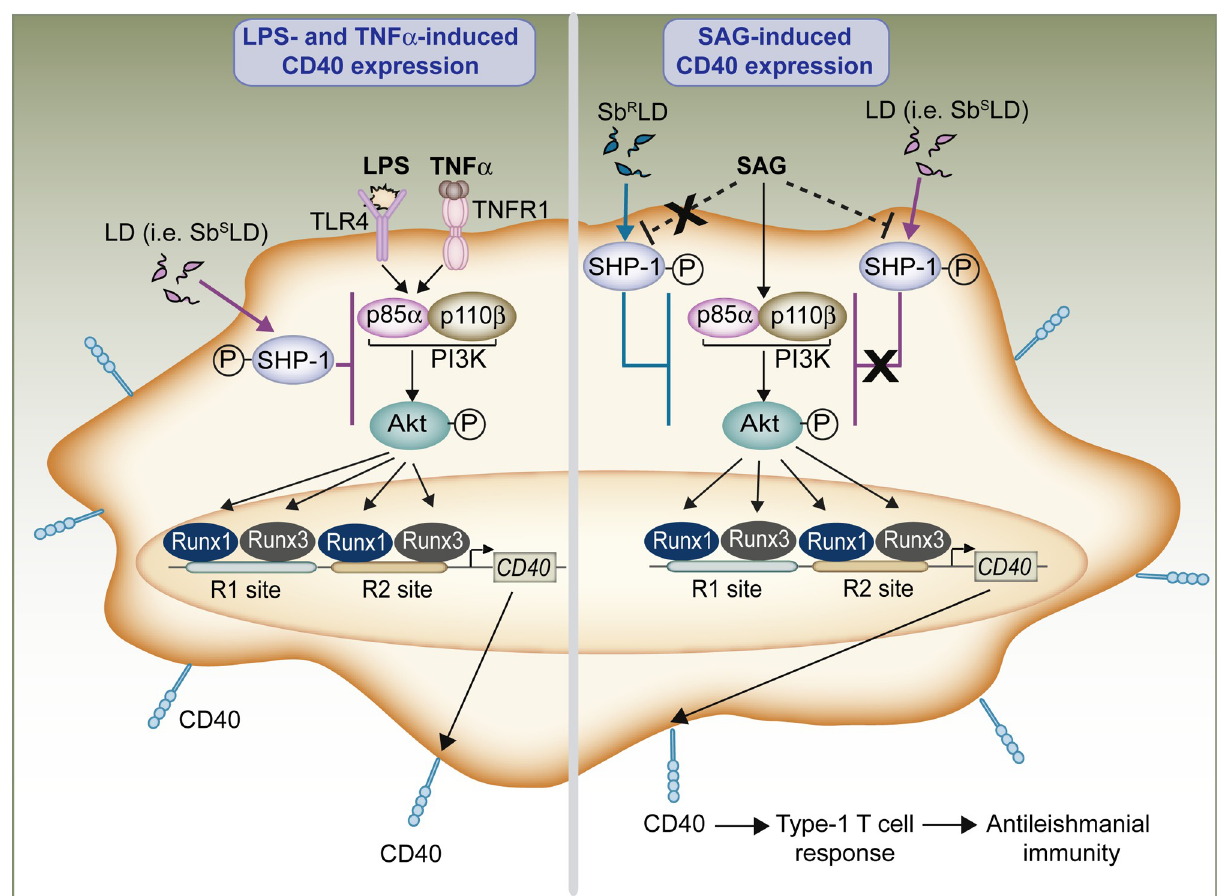
Fig 13. Model depicting the Runx-CD40 axis as a molecular key for antileishmanial immunity. Our results show that the proinflammatory mediators LPS and TNF α , and antileishmanial drug SAG, through PI3K (p85 α -p110 β )-Akt signaling pathway, induce the binding of Runx1 and Runx3 transcription factors to the CD40 promoter and consequently upregulate CD40 expression on DCs. The CD40 upregulation induced by LPS or TNF α , however, is inhibited by normal LD (i.e., Sb S LD; left panel). LD mediates this inhibitory effect by suppressing the PI3K (p85 α -p110 β )-Akt-Runx pathway through SHP-1. In contrast, SAG-induced CD40 upregulation on DCs remains unaffected by normal LD infection (right panel). This is because SAG, by blocking (directly/indirectly; indicated by dotted lines) LD-induced SHP-1 activation, enables the PI3K (p85 α -p110 β )-Akt -Runx pathway to upregulate CD40 expression on LD-infected DCs. The upregulated CD40 expression in turn augments type-1 T cell responses that confer protection against LD infection. Unlike normal LD (Sb S LD); Sb R LD, however, suppresses the PI3K-Akt-Runx pathway-mediated CD40 upregulation on DCs by persistently activating SHP-1 despite SAG treatment. Thus, acting as a critical mediator of CD40 expression in DCs, Runx proteins play a pivotal role in mounting antileishmanial immunity.